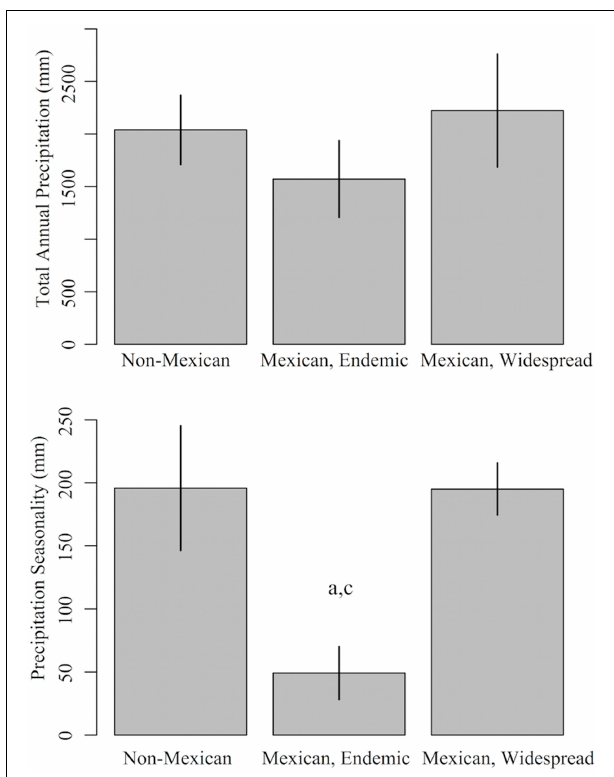
FIGURE 2 | Precipitation profiles of Mexican and non-Mexican Malpighiaceae. Mexican Malpighiaceae are subdivided into two groups: endemic lineages that are geographically restricted to Mexico, and wide-ranging lineages that also occur outside of Mexico. The two climate variables are: total annual precipitation (mm yr − 1 ) and seasonal precipitation (total precipitation during the driest quarter, mm yr − 1 ). Error bars indicate standard errors. Significant ( P < 0 . 05) differences in mean values between groups based on a comparison with phylogenetic generalized linear models are indicated by a (Non-Mexican), b (Mexican, Endemic), and c (Mexican,